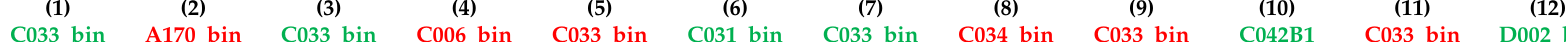
Predictors/Response